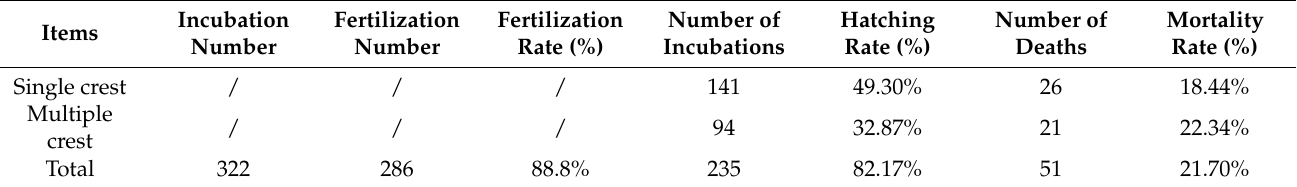
Table 2. Effect of crested cushion number on reproductive performance of RWC